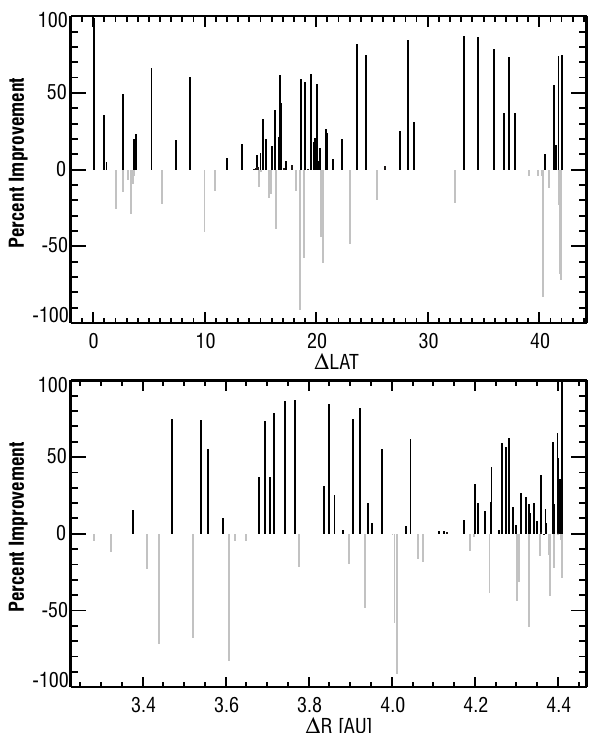
Fig. 8. Amount of improvement in sector agreement. Cases where the source longitude adjustment agreed better with the model are shown in black and cases where the radial propagation along agreed better are shown in grey. The length of the lines represents the dif- ferences in the level of agreement for the two